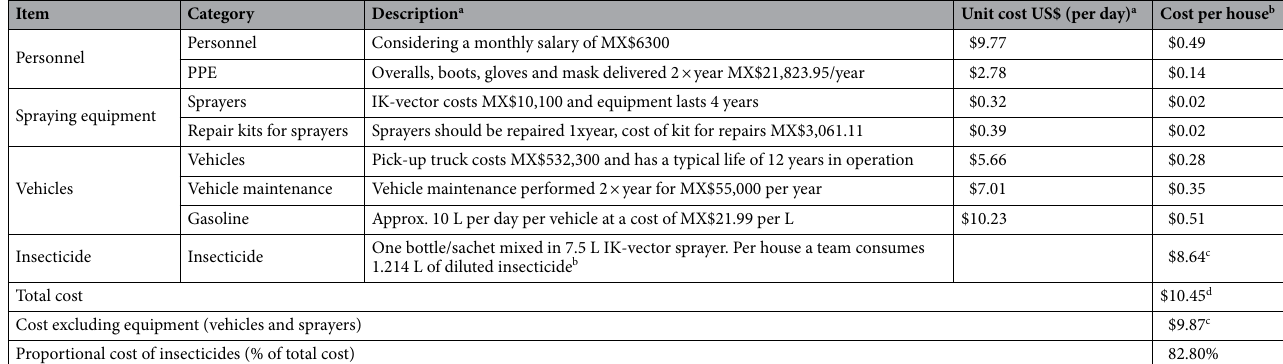
Table 2. Estimated costs of implementing preventive TIRS in Merida, Mexico. a Considering a 2020 average exchange rate of MX$21.49 per 1 US$. b Assuming an average efficiency of 18 houses/day per team. c Considering the amount paid by Mexico’s MOH for Actellic 300CS (US$54/bottle) in 2018, and using the following equation: (US$54*1.2 L)/7.5 L =. d Assuming a cost of insecticide of $15 per bottle (Global Fund cost of Actellic 300CS and SumiShield 50WG) 36 total costs per house would be $4.23 (and $3.57 if equipment costs are